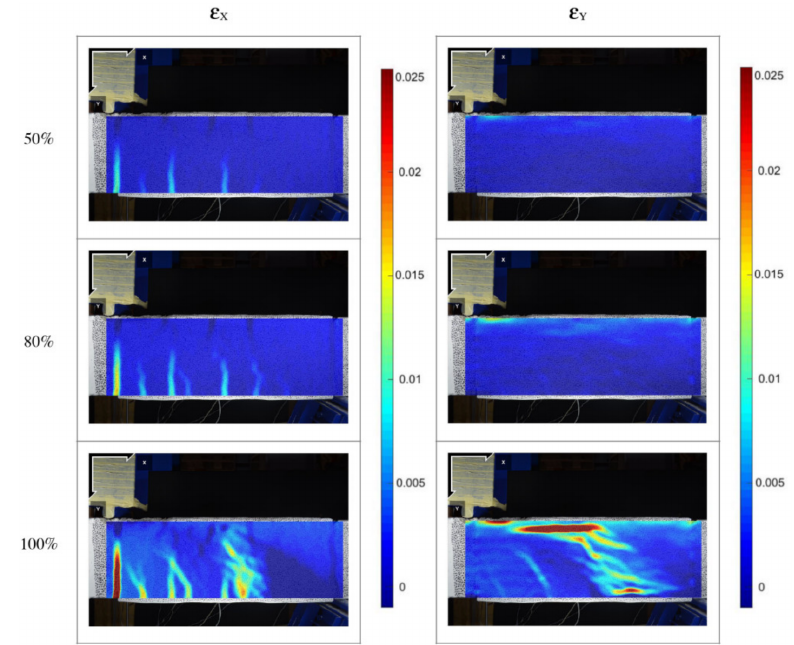
Figure 11. B-C-2L: Strain evolution obtained by using DIC